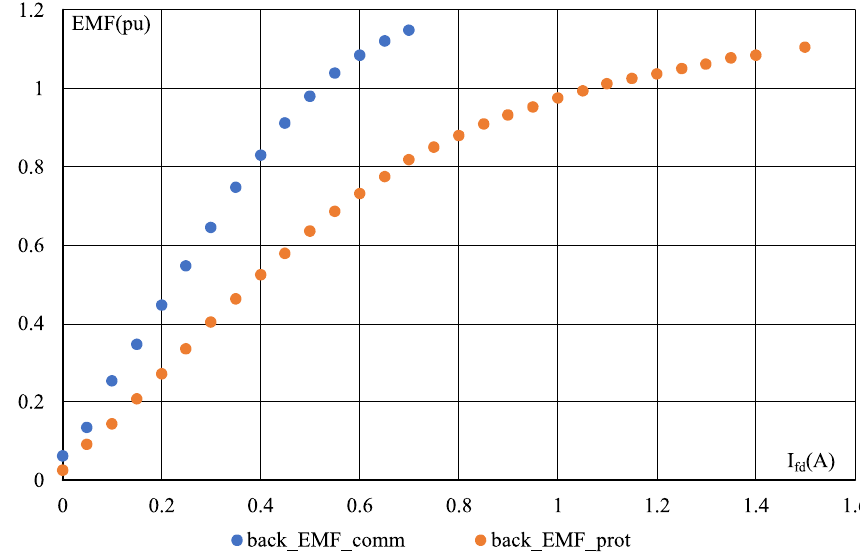
Figure 10. No-load EMF measurements (line to line value) in the function of the exciter field current for commercial generator (back_EMF_comm) and prototype generator